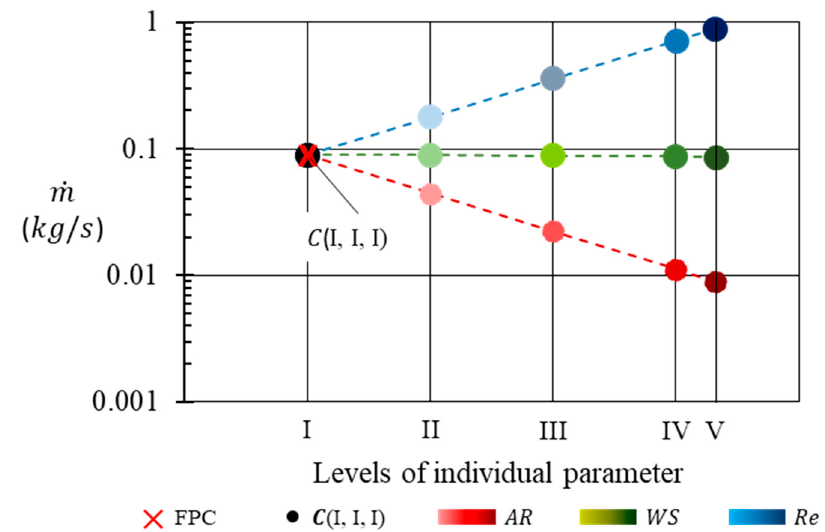
Figure 18. Mass flow rate variation with parameter.